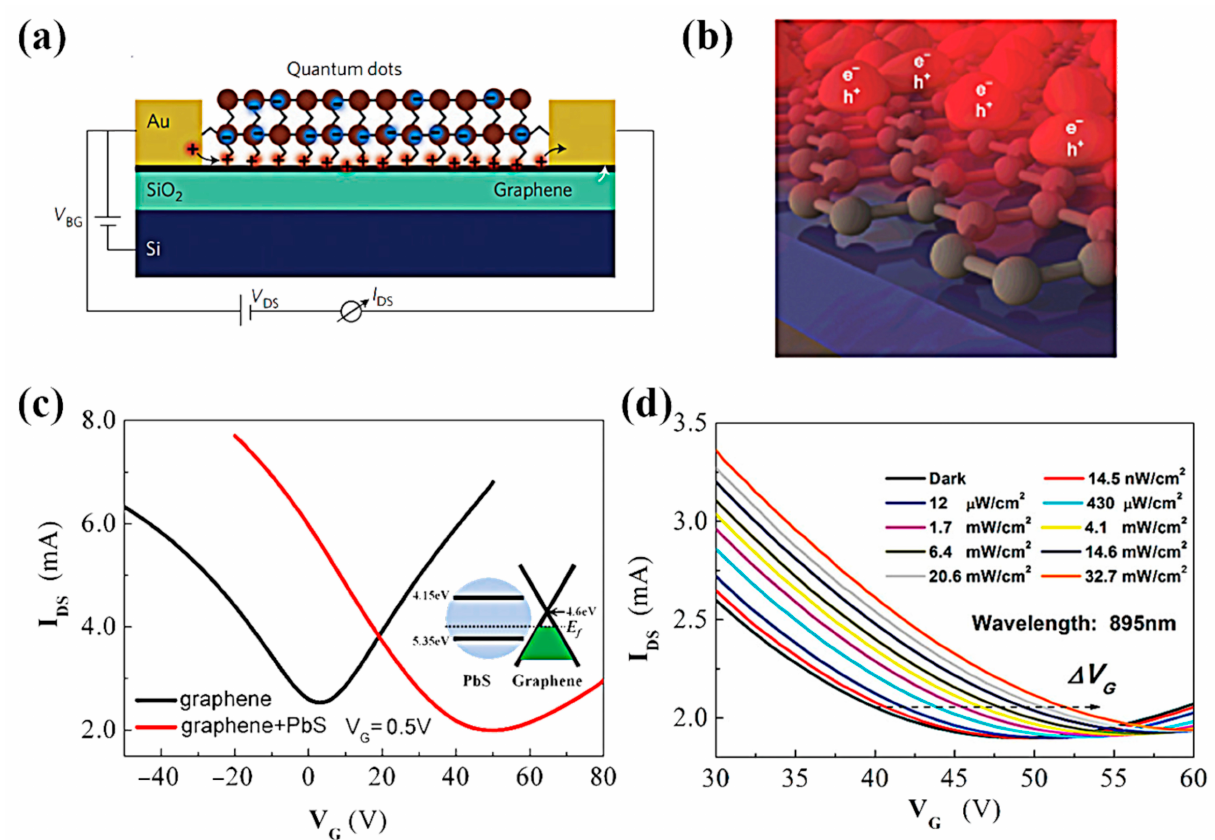
Figure 3. Photogating Effect. ( a ) Schematic of the graphene–quantum dot hybrid phototransistor. ( b ) Illustration of the interface charge distribution between nanoparticles and graphene. ( c ) Transfer characteristics of graphene transistors with or without the addition of PbS QDs on the graphene film. Inset: Energy diagram of the heterojunction of PbS QD and graphene. ( d ) Transfer characteristics of a PbS QDs/graphene transistor characterized under different light irradiation with the wavelengths of 895nm. ( a ) Reproduced with permission from [19]. Copyright Nature Publishing Group, 2012. ( b ) Reproduced with permission from [53]. Copyright Nature Publishing Group, 2017. ( c , d ) reproduced with permission from [52]. Copyright Wiley,